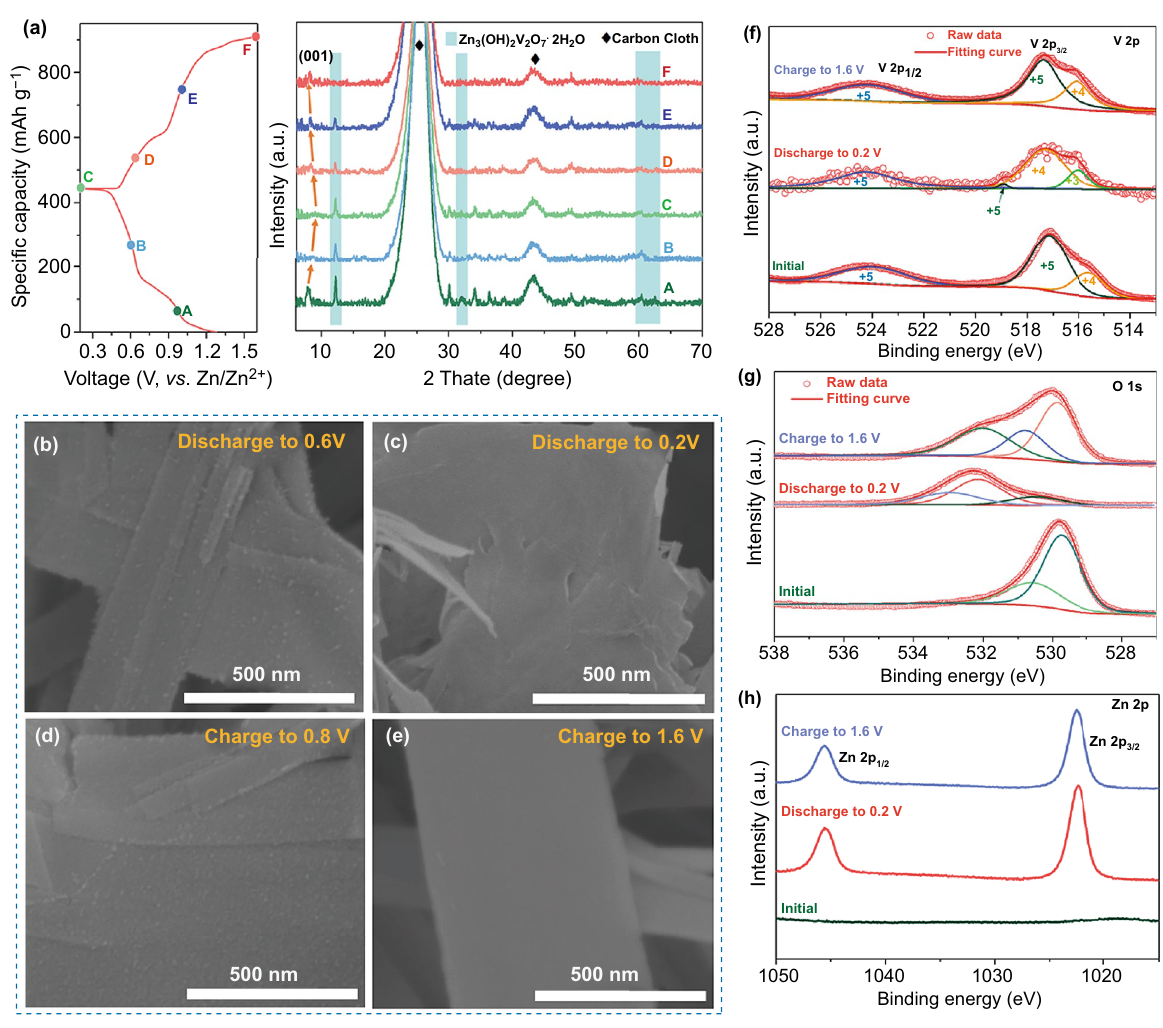
Fig. 5 Electrochemical reaction process studies. a Ex situ XRD patterns of NVO in different discharge/charge states, the shifts and recovery of (001) peaks suggest a reversible reaction in the electrochemical processes. Ex situ SEM of NVO in the first discharge/charge process, b discharge to 0.6 V, c discharge to 0.2 V, d charge to 0.8 V, e charge to 1.6 V. Ex situ XPS spectra of f V 2p, g O 1 s, h Zn 2p in the initial, discharge to 0.2 V and charge to 1.6 V states in the first